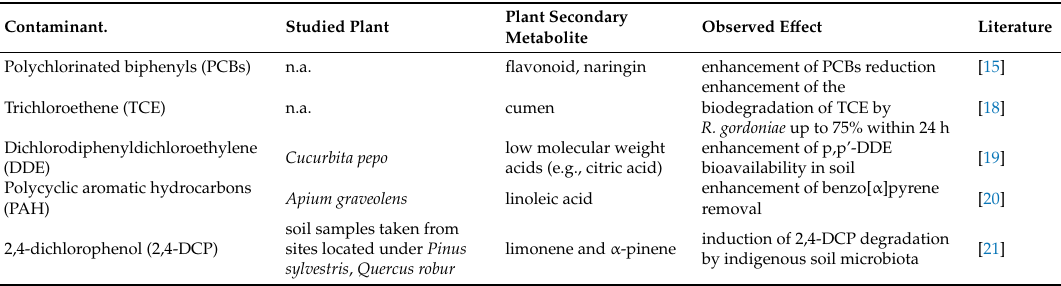
Table 1. Examples of PSMs and Their E ff ect on the Biodegradation of Selected Contaminants.